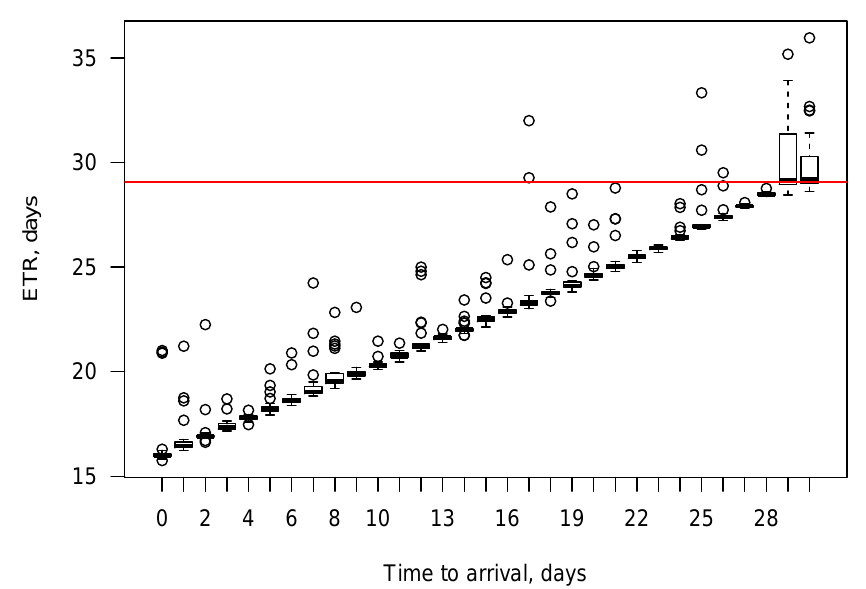
Figure 12. Changing time to arrival of 150 mutual assistance crews added to 200 initial crews for extreme storm. Crew start location set to area work center and search strategy set to nearest outage. Travel speed set to 25 mph. 85% crews working during day shift, 99% working during evening shift and 66% working during night shift, 1 to 10-h repair time range. The horizontal red line shows the median ETR of 0 added crews. The ETR increases with increasing time to arrival of the mutual assistance crews.